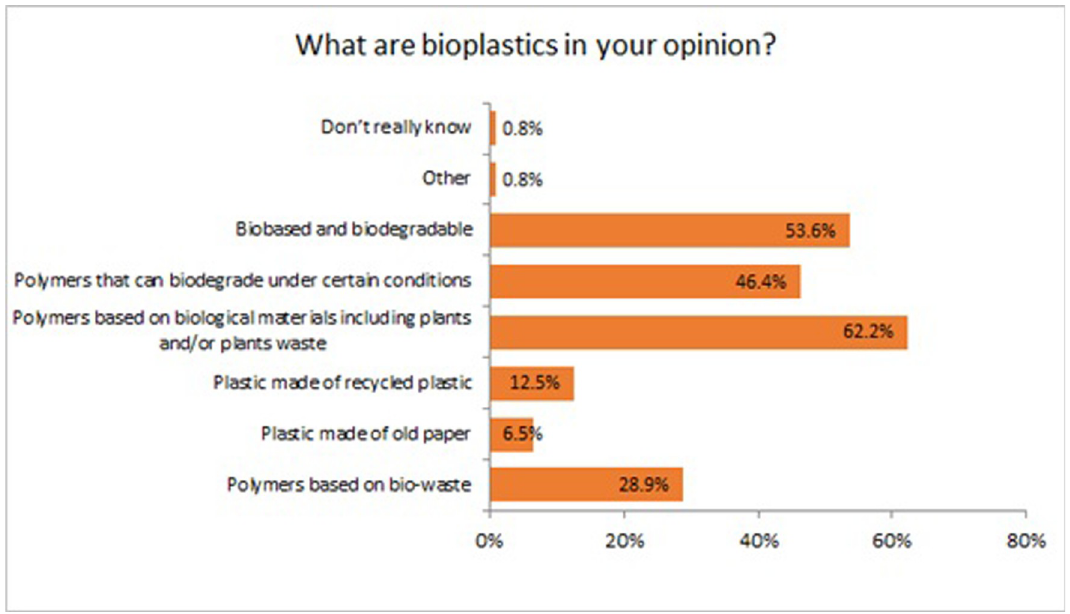
Fig 2. Respondents’ basic knowledge of bioplastics (n =